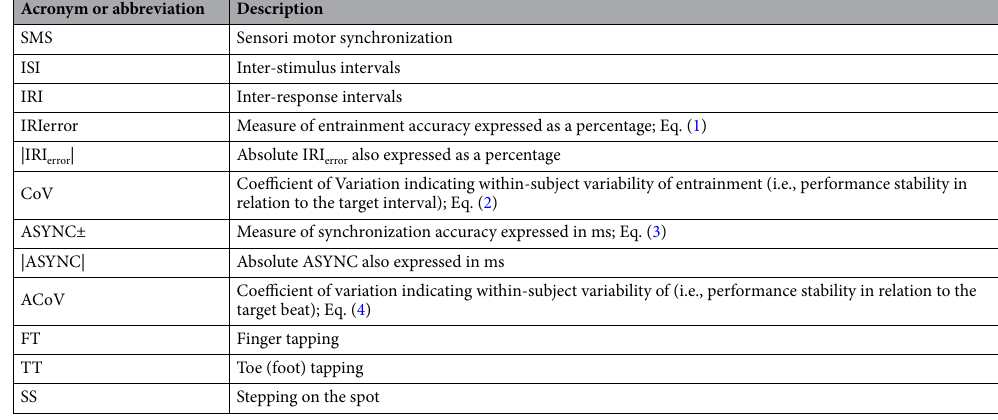
Table 2. Glossary of